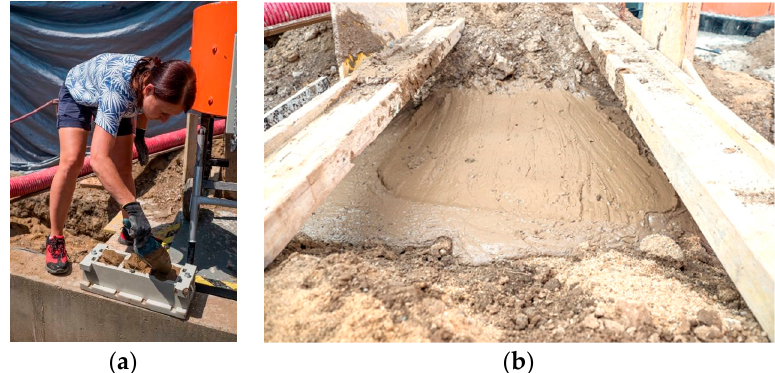
Figure 9. ( a ) Sampling of fresh grout for determination of the main parameters; ( b ) excavation filled with grout.